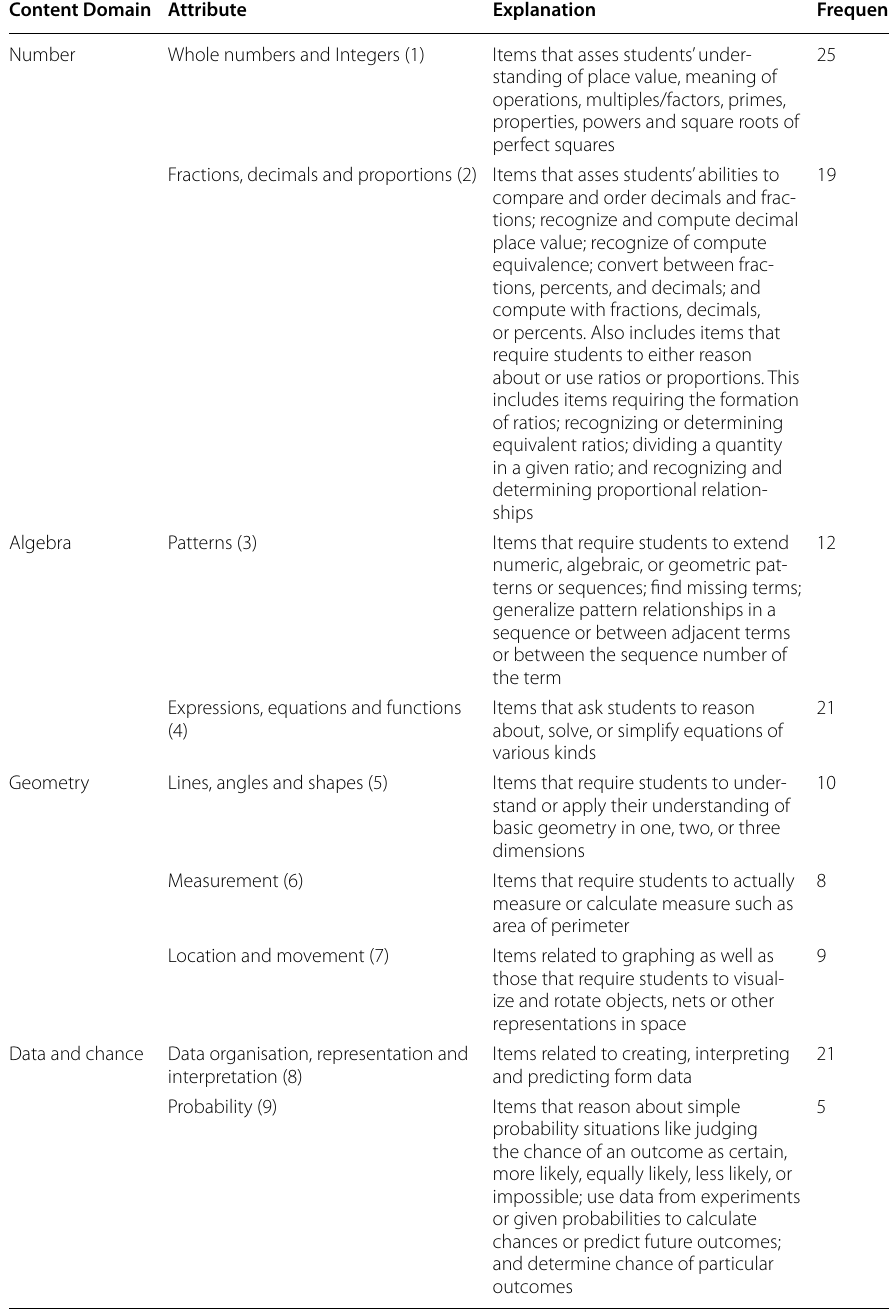
Attributes and frequency adopted from Johnson et al.